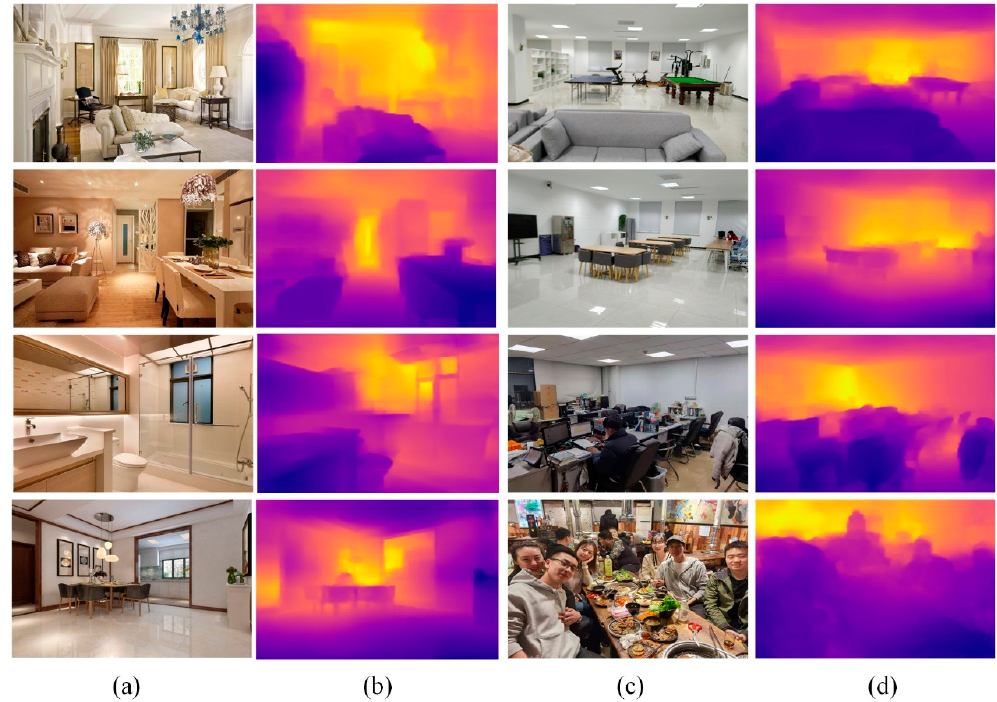
Figure 9. The results of the proposed method on the collected samples. ( a ) Images from the internet; ( b ) proposed method; ( c ) images captured with a mobile phone; ( d ) proposed method.